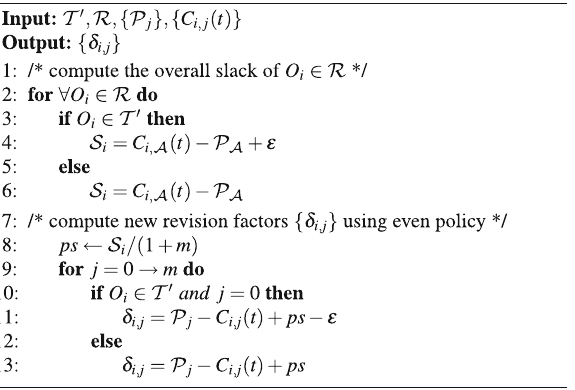
algorithm reallocates the numeric values of violated data objects by assigning revision factors to distributed